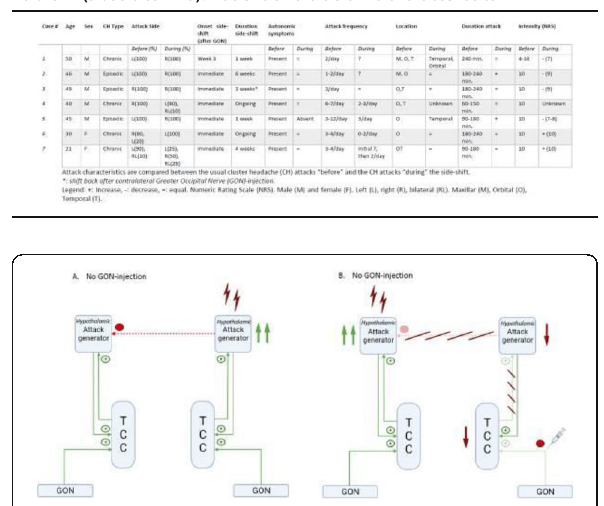
Fig. 1 (abstract P18). Proposed mechanism of side-shifts after GON injection